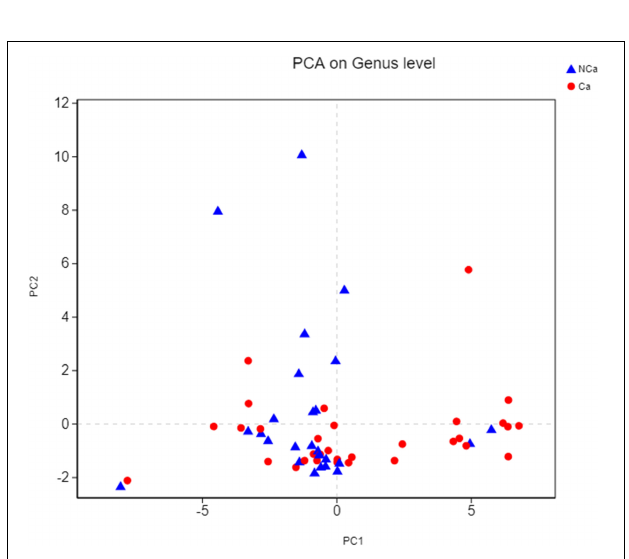
FIGURE 3 | PCA on genus